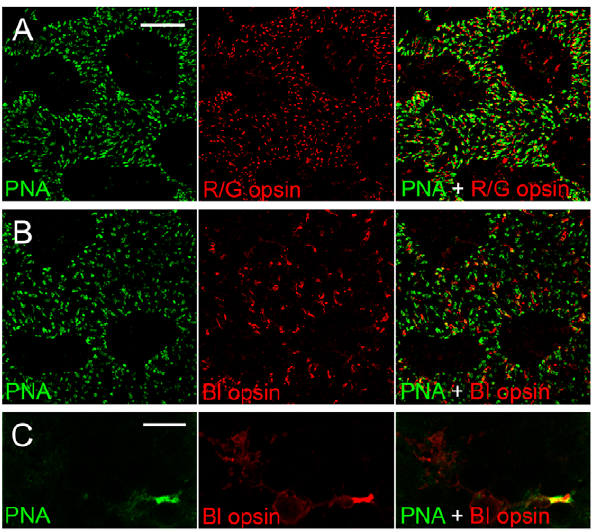
Figure 4. Specificity of PNA staining to COS. Whole-mounted retinas (superior regions) of S334ter-3 rats (PD 30) were double stained with PNA and antibodies against red/green opsin (A) or blue opsin (B). PNA-staining overlaps with red/green opsin or blue opsin staining very well. The specificity of PNA staining to COS was confirmed under high magnification (C). PNA stained almost exclusively COS (C), whereas antibodies against blue opsin stained not only COS, but also, to a lesser degree, the inner segment, the cell body, and the synaptic terminal (C). Scale bar: 50 m m for A and B; 10 m m for C.